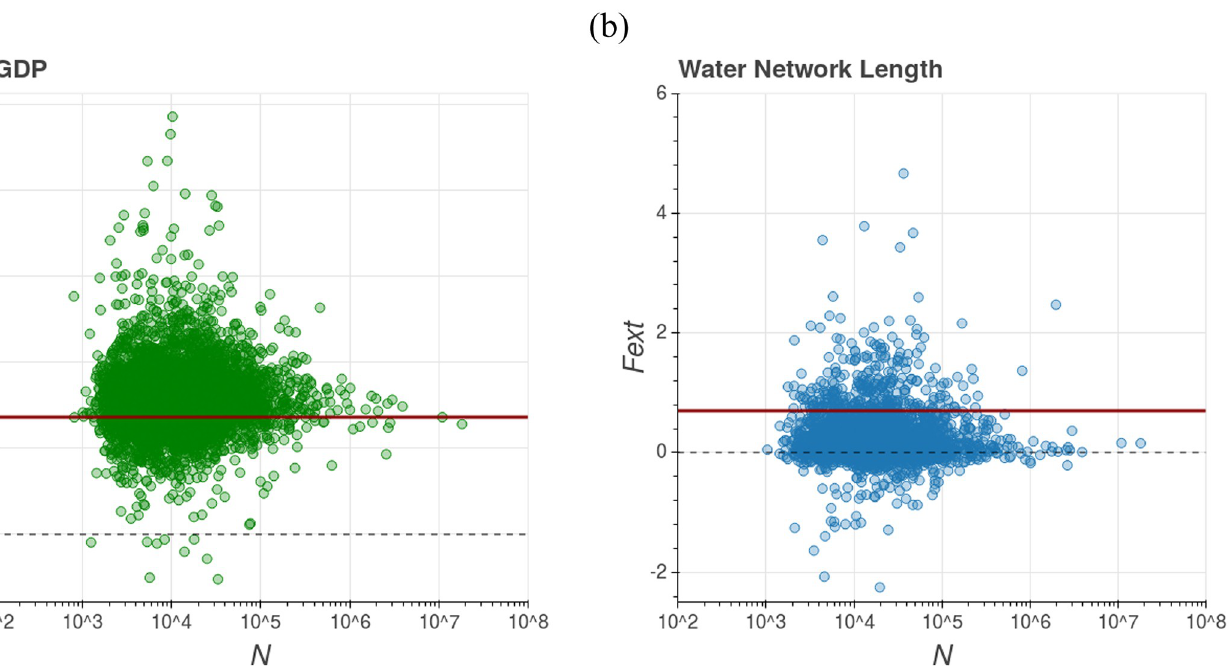
PLOS ONE | https://doi.org/10.1371/journal.pone.0233003 May 19,